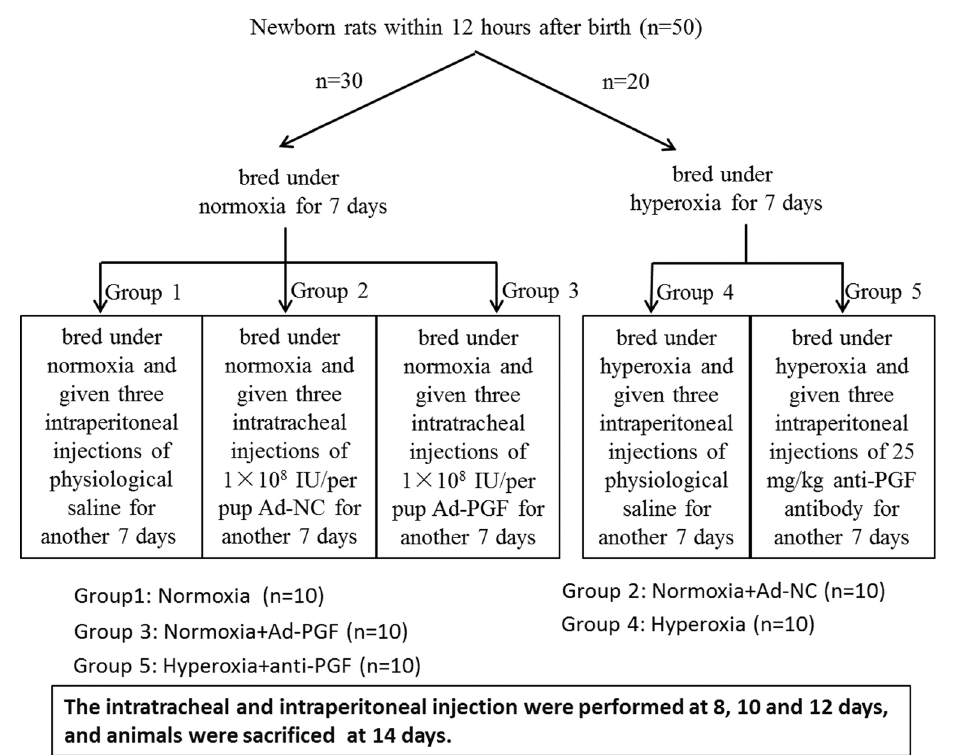
Figure 1. Flow chart of the method used for generating the experimental animal model. Ad-NC: adenovirus-negative control; Ad-PGF: adenovirus-placental growth factor.